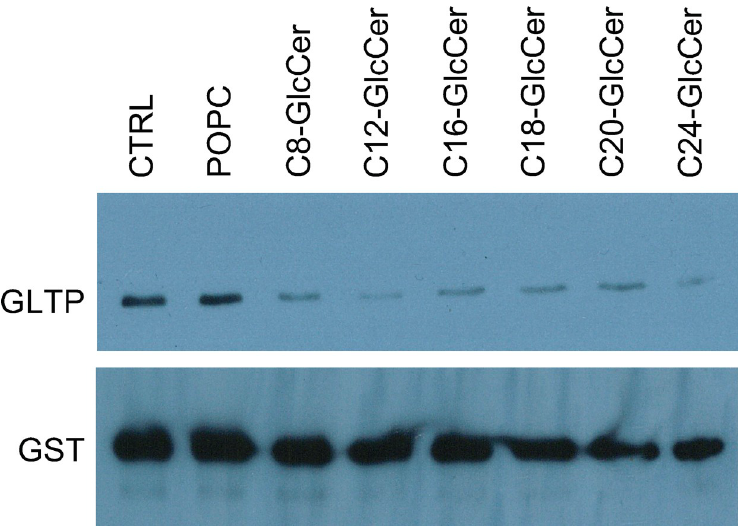
Fig 6. GlcCer dependent GLTP and VAP-A binding. Pull-down assays with subsequent Western blott analysis of GLTP with bound GlcCer and VAP-A. The GST-tagged VAP-A was pulled-down using glutathione sepharose beads and washed, carrying along any bound GLTP. The upper blot is anti-GLTP and the lower blot anti-GST antibodies. In the lane indicated with CTRL only GLTP and VAP-A was pulled down, the lane indicated POPC contains GLTP, POPC and VAP-A. The blot shown is representative of three different independent